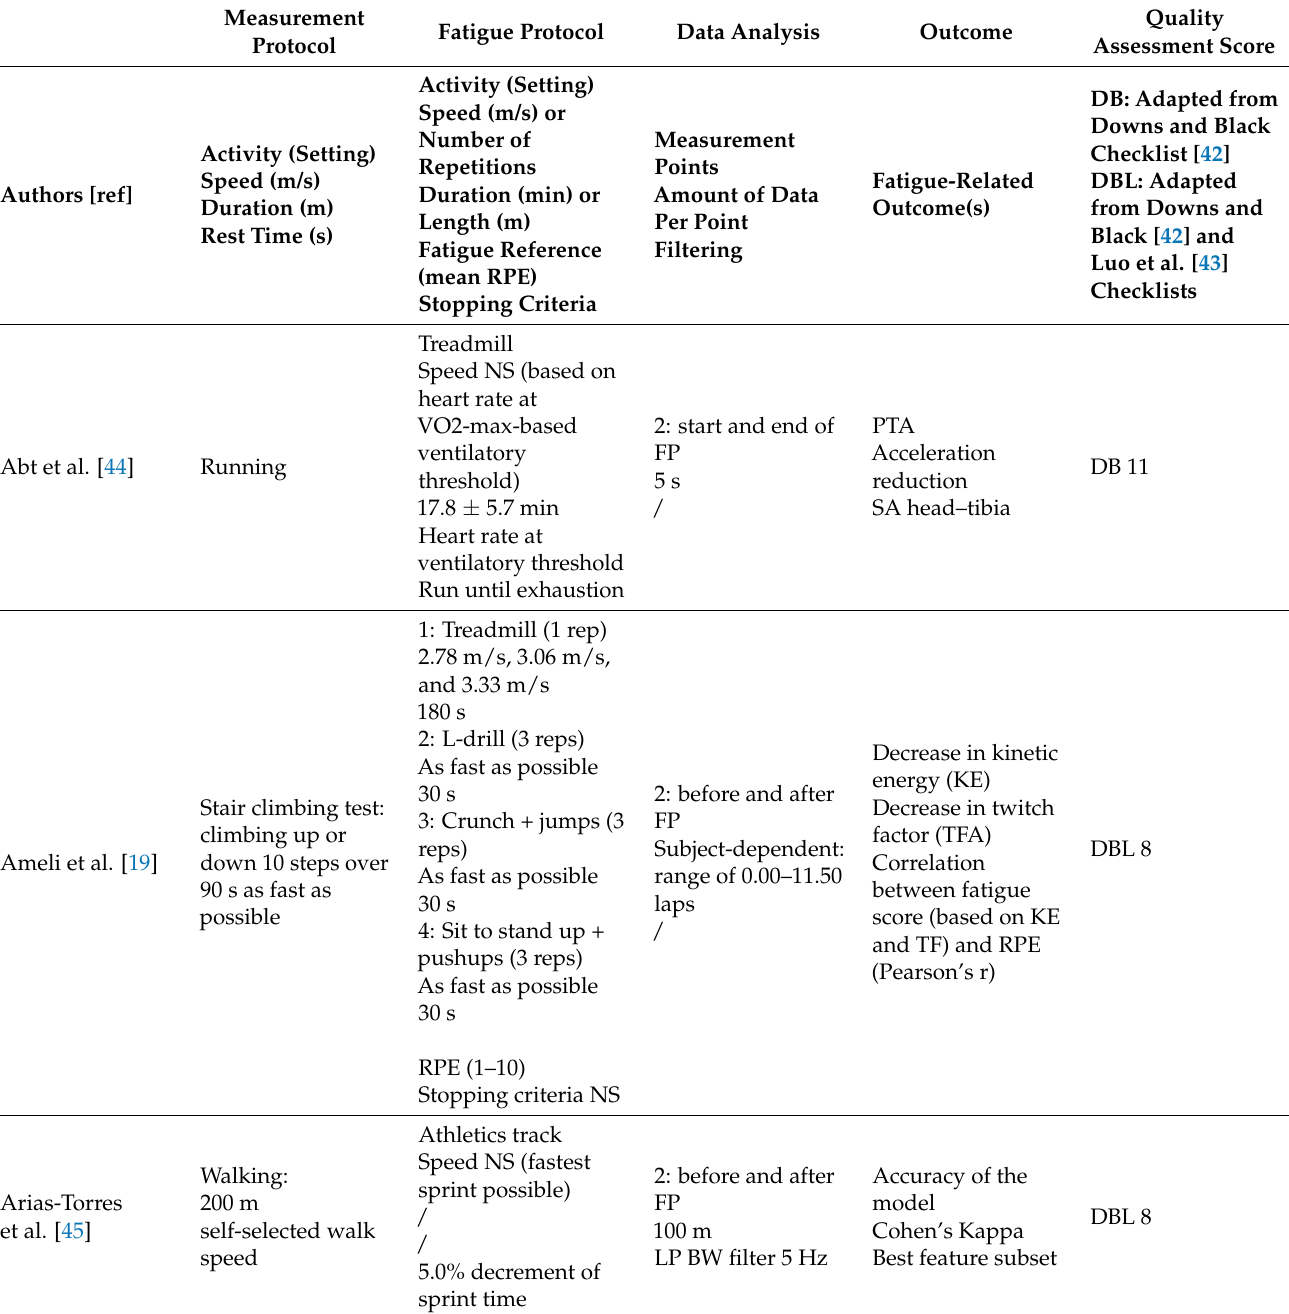
Table 4. Study protocol, data analysis, outcome(s) of interest, and quality assessment